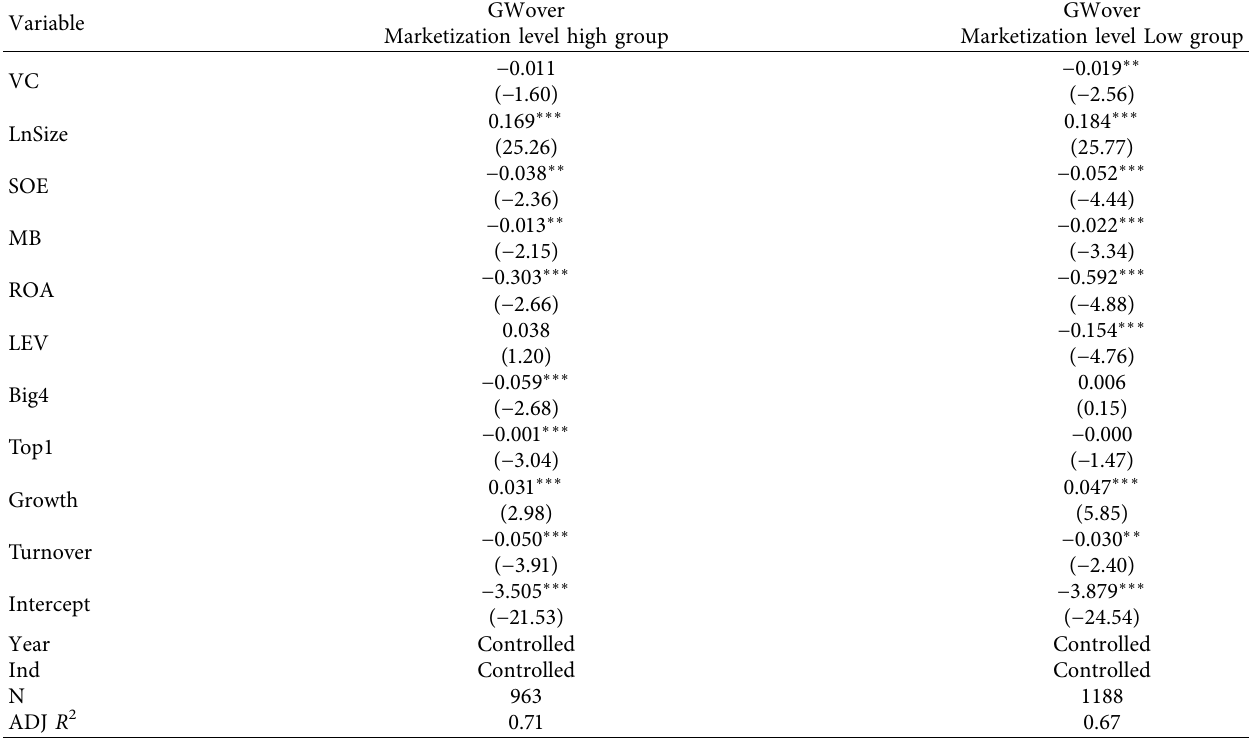
Table 15: Regression results of external